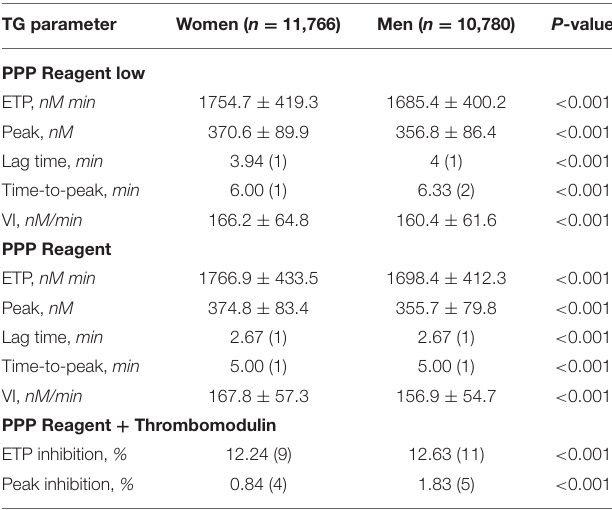
TABLE 1 | General characteristics of the Moli-sani cohort, stratified by sex. Variable